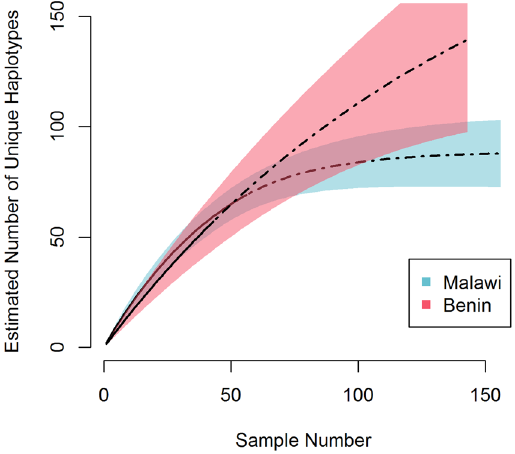
Figure 3. Rarefaction curves of ID1-DBL2x variants in Malawi (blue) and Benin (red). Calculated rarefaction curves are represented by solid lines. Extrapolated curves are depicted by dotted lines. The rarefaction curves were bootstrapped 1000 times to generate the 95% confidence intervals (CIs), which are represented by lightly shaded red and